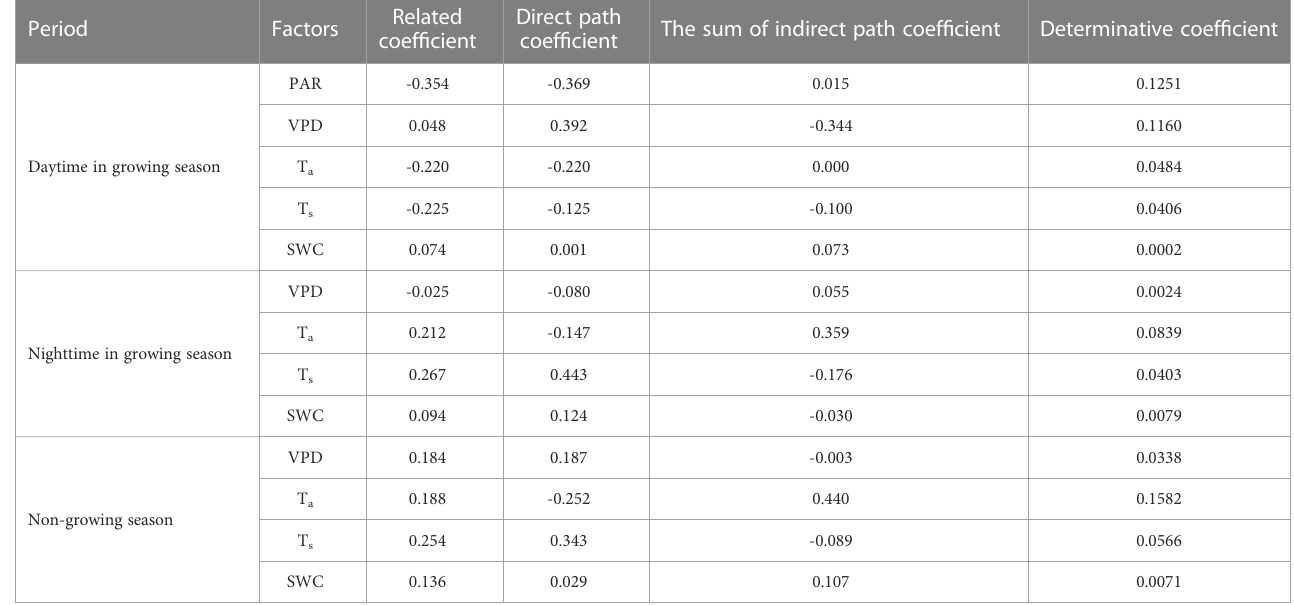
TABLE 1 Direct and indirect path coef fi cients of environmental factors on NEE (net ecosystem CO 2 exchange) diurnal variation.